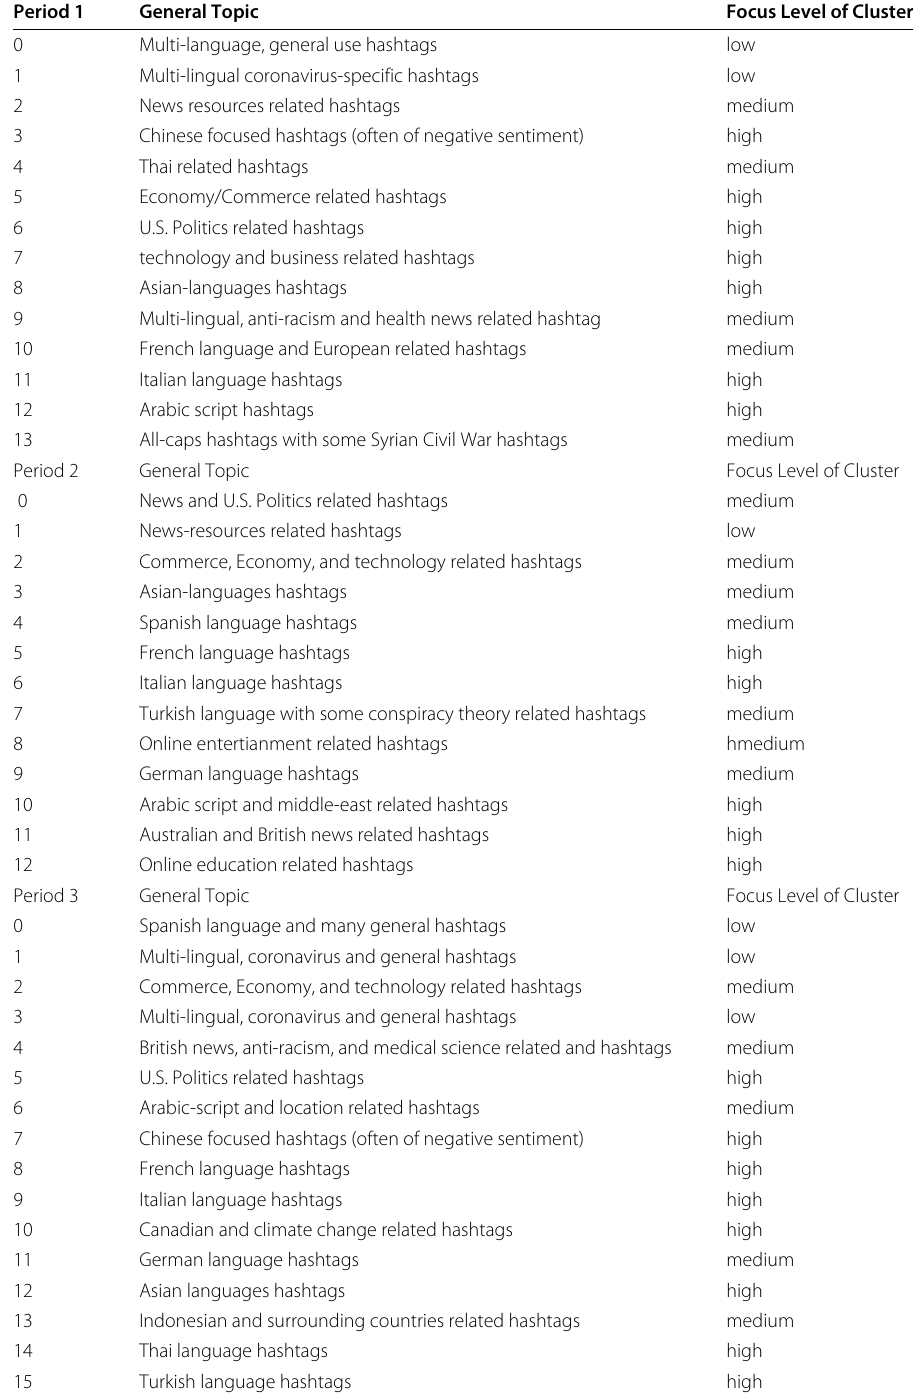
Table 2 Topical labels for the temporally-ensembled meta-clusters Period